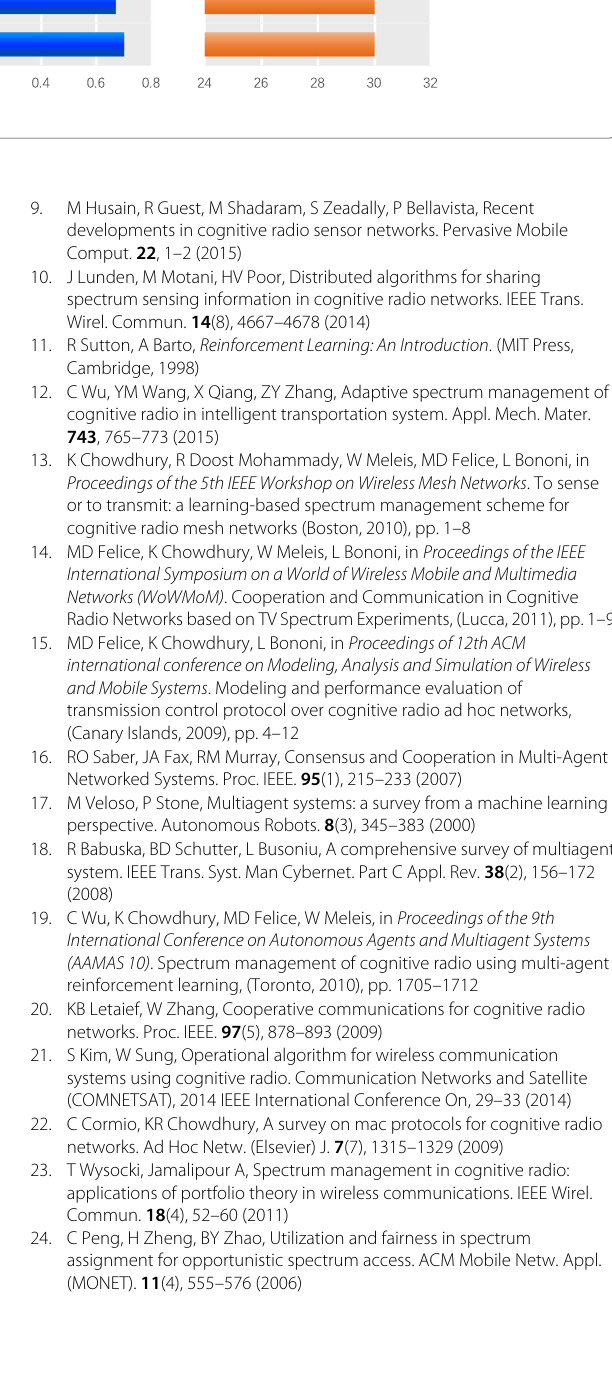
Fig. 8 The network energy after 600 epochs